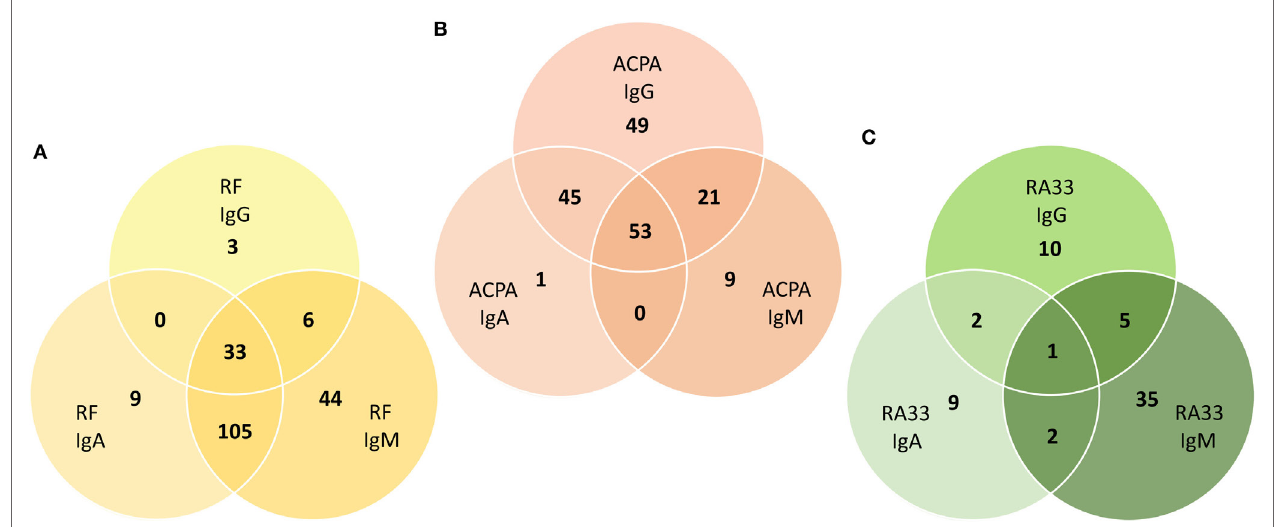
FigUre 2 | Isotype distribution of rheumatoid factor (RF), anti-citrullinated protein antibodies (ACPA), and RA33 antibodies among antibody positive patients. Venn diagrams visualizing the overlap between (a) RF, (B) ACPA, and (c) RA33 IgA, IgG, and IgM isotypes. The major RF subtype is IgM largely overlapping with IgA and IgG subtypes. The major ACPA subtype is IgG largely overlapping with IgA and IgM subtypes. The major RA33 subtype is IgM but there is little overlap with the IgA and IgG